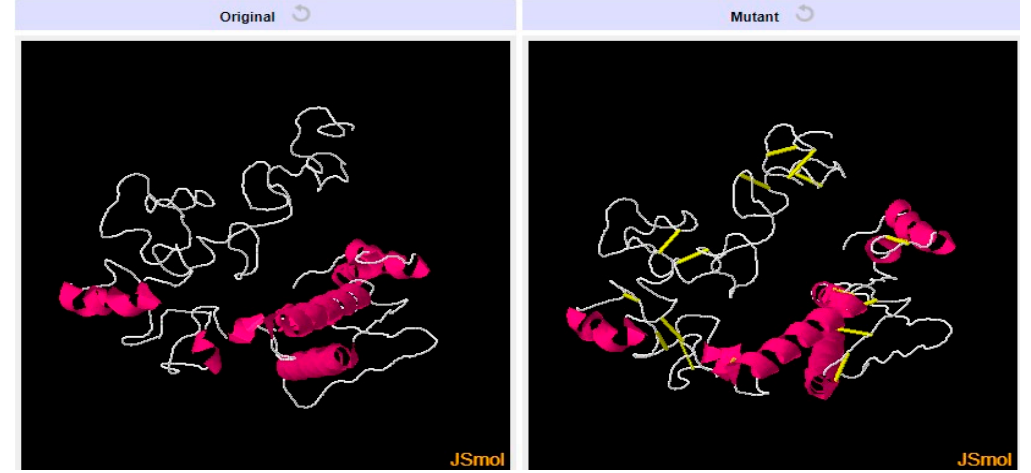
Figure 6. Left side structure represents original structure while right side structure represents the mutated structure of final vaccine construct.